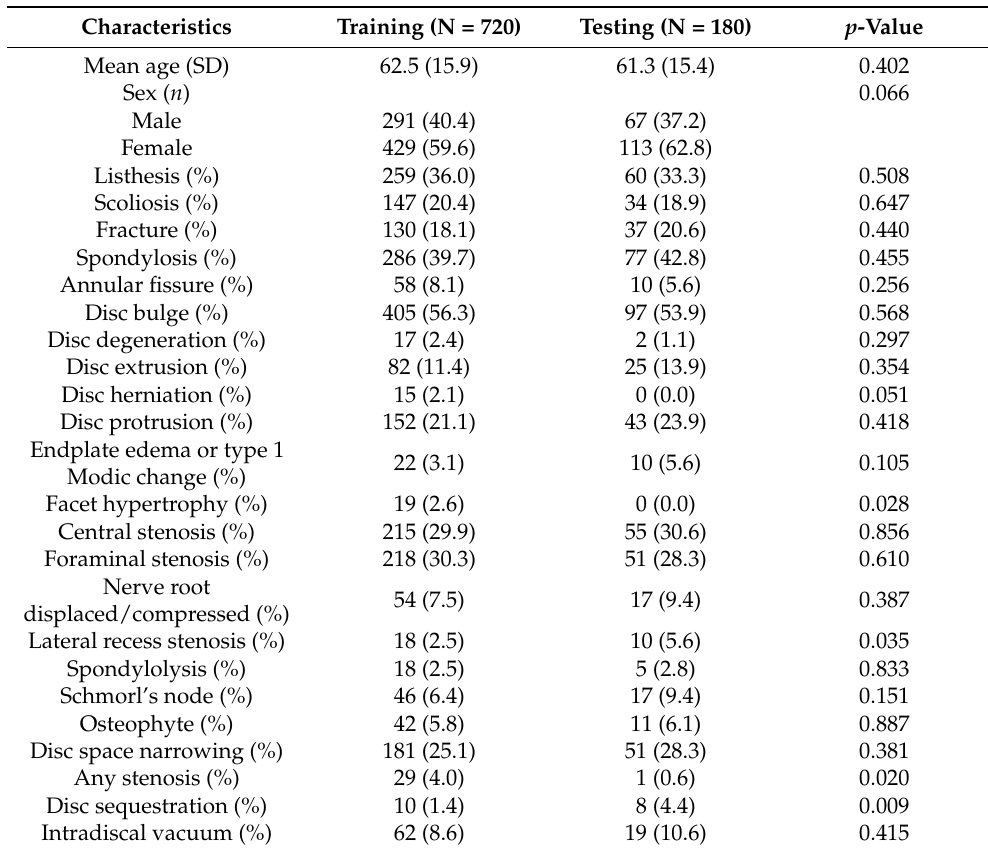
Table 2. Characteristics of training and testing datasets for the development of the natural language processing